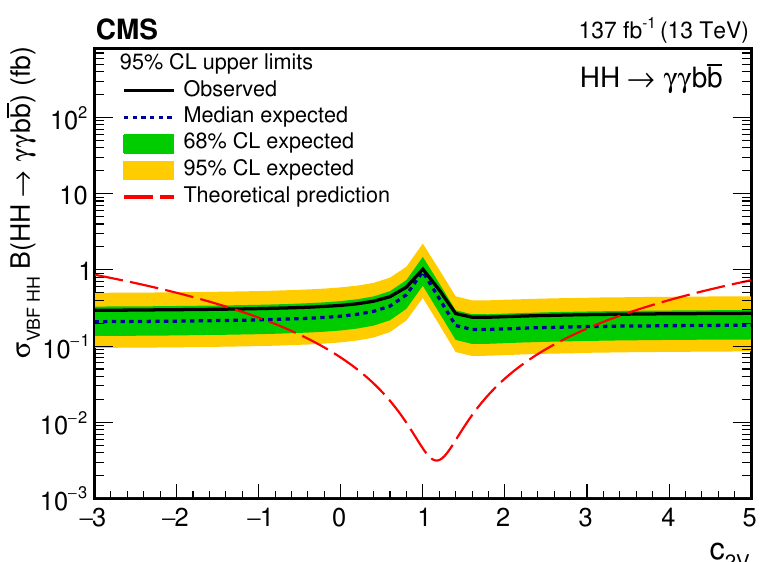
Figure 14 . Expected and observed 95% CL upper limits on the product of the VBF HH production cross section and B (HH → γγ bb) obtained for different values of c represent, respectively, the one and two standard deviation extensions beyond the expected limit. The long-dashed red line shows the theoretical